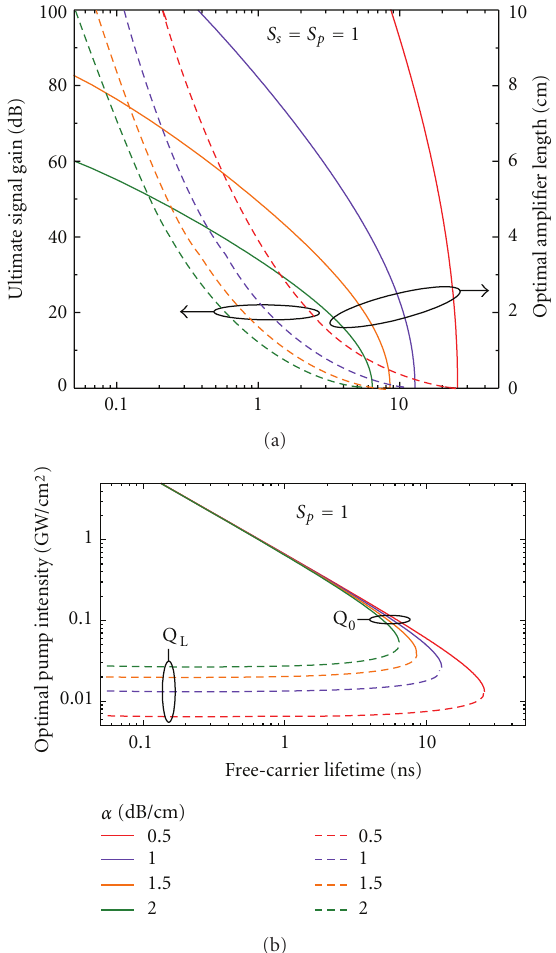
Figure 1: (a) Ultimate signal gain (dashed curves) and optimal amplifier length (solid curves) plotted as functions of τ c for an SRA operating in the undepleted-pump regime when S s = S p = 1; di ff erent colors correspond to di ff erent values of α s = α p ≡ α . (b) Input and output pump intensities calculated as a function of τ c using (10) with S p = 1. Refer to text for other